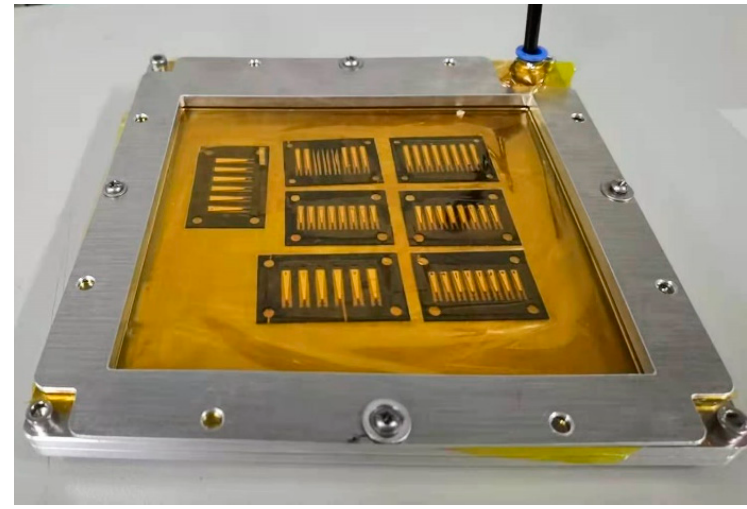
Figure 5. The vacuum bag.